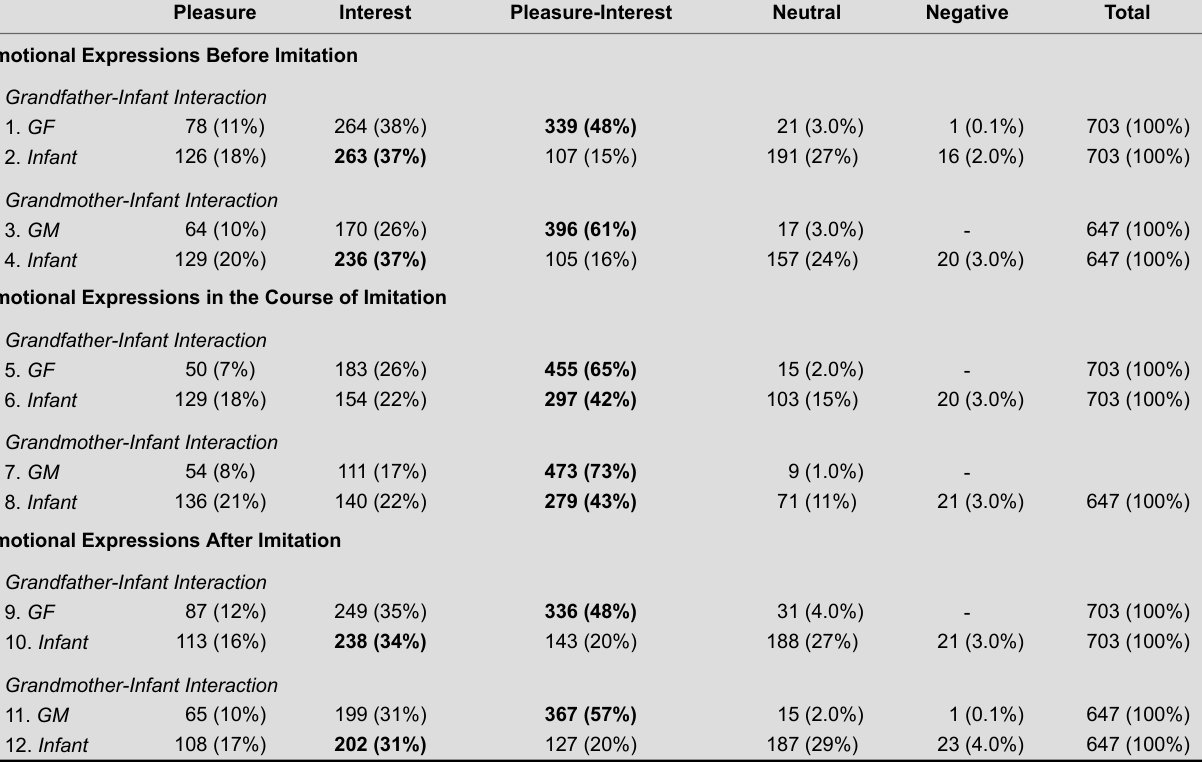
Frequencies (Percentages) of Infant, Grandfather (GF) and Grandmother (GM) Emotional Expressions Before, During and After Imitation